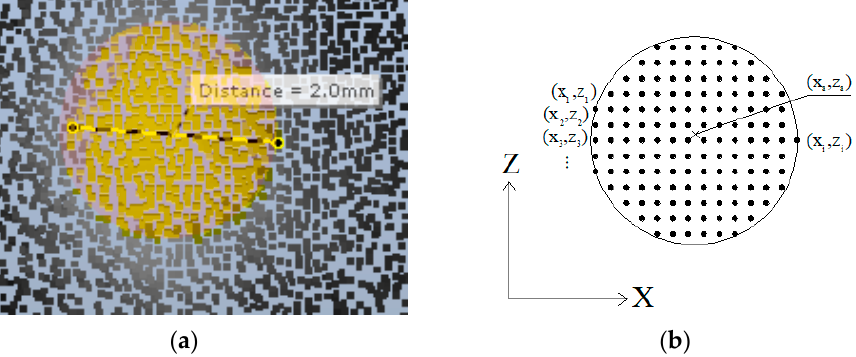
Figure 19. Point cloud within the measuring point: ( a ) selection of points; ( b ) determining the center of the circle as the measuring point.